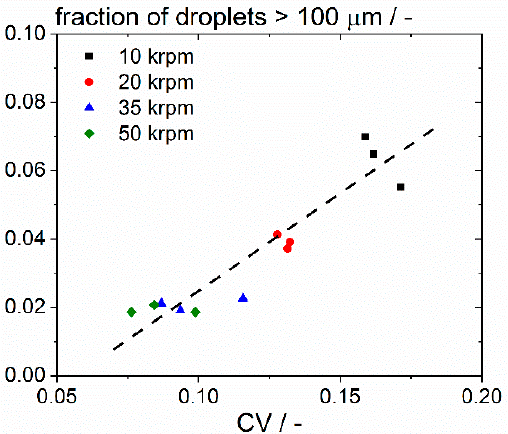
Figure 9. Fraction of droplets larger than 100 μ m vs. coefficient of variation CV for different rotational speeds n . The line is to guide the eye.